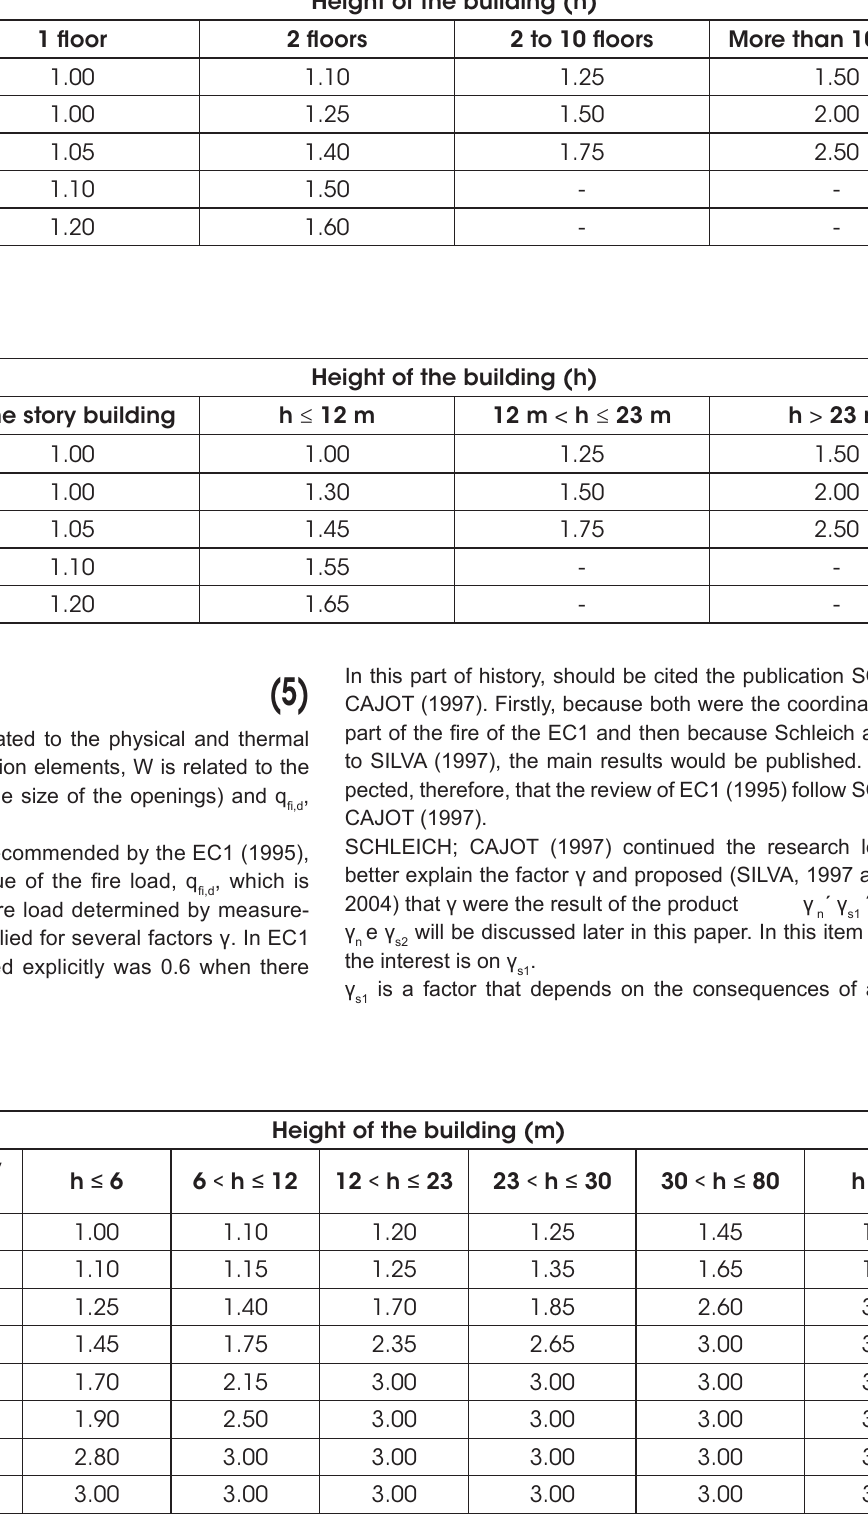
Values of γ (SCHLIECH; CAJOT, 1997) s1 Compartment area